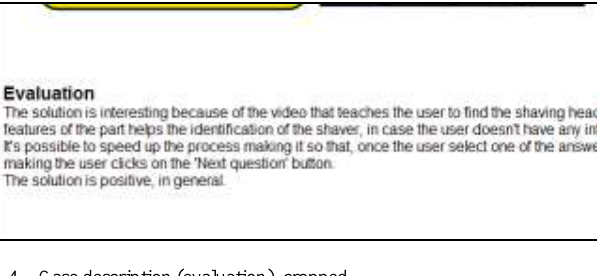
Fig. 4. Case description (evaluation),